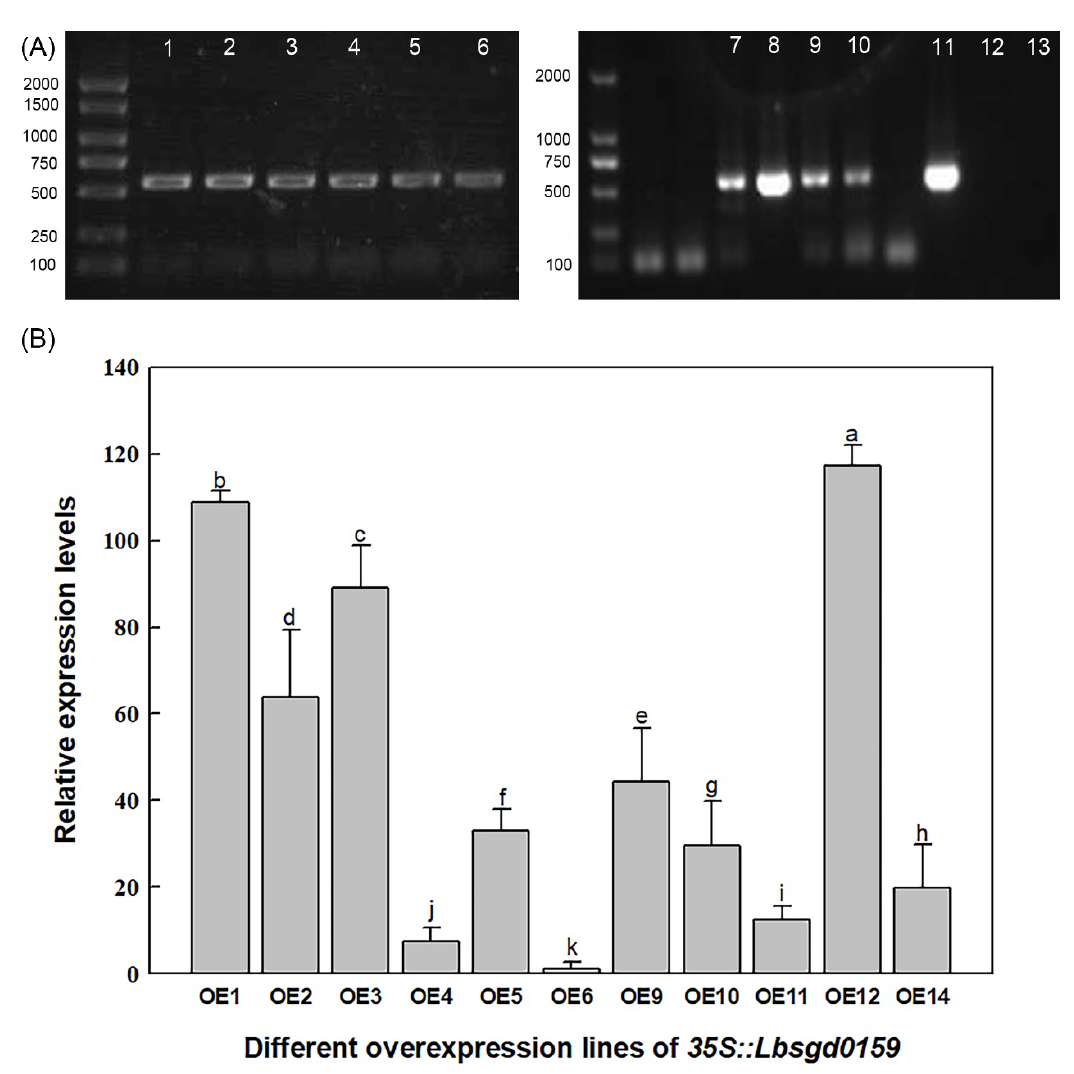
Figure 3. Molecular identification and expression analysis of Arabidopsis Col-35S:: Lb1G04202 lines. ( A ) PCR of genomic DNA from Col-35S:: Lb1G04202 lines. Lanes 1–6, 7–10 and 11, different transgenic lines; lane 12, blank control with ddH 2 O used as a template; lane 13, negative control with wild-type DNA used as a template. ( B ) Expression levels of Lb1G04202 in Col-35S:: Lb1G04202 lines examined by qRT-PCR. Data are means ± SD of three replicates; different letters indicate significant differences at p = 0.05 according to Duncan’s multiple range test.